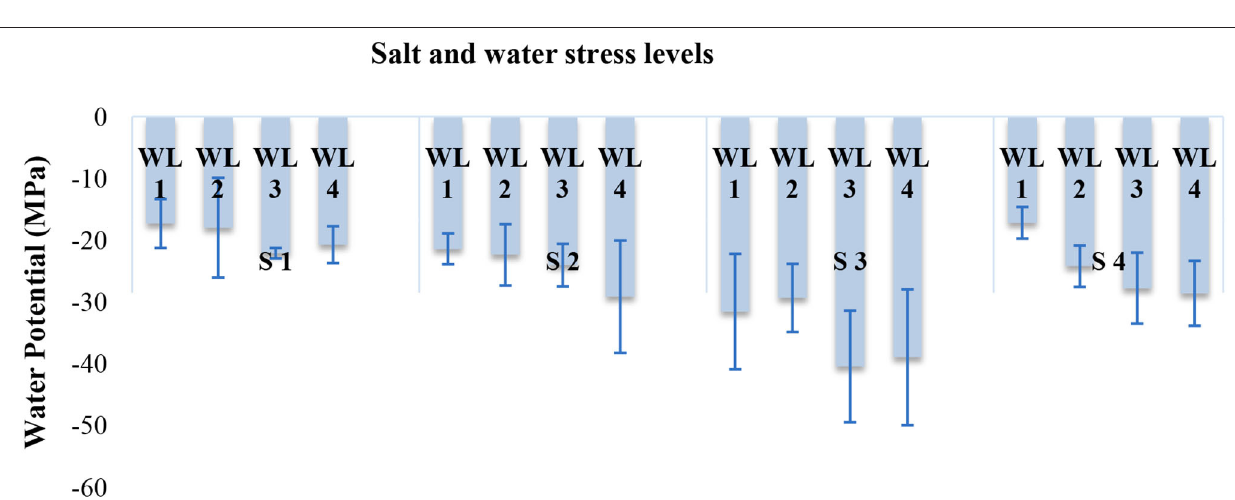
Figure 2 | Interactive effect of salinity and drought stress on the water potential (MPa) of S. imbricata . Error bar represents the standard error of mean ( n = 3). WL stands for water level (WL1 = 100% field capacity, WL2 = 80% field capacity, WL3 = 60% field capacity, and WL4 = 40% field capacity), while S represents